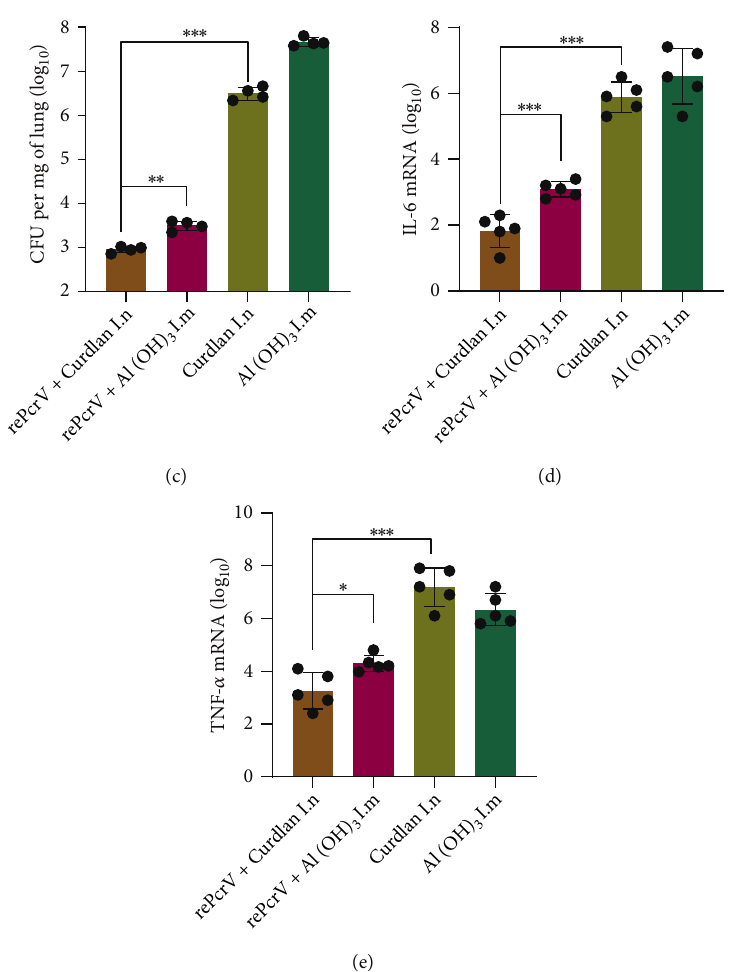
Figure 1: Intranasal vaccination (i.n.) with rePcrV enhanced protection compared with intramuscular vaccination (i.m.). (a) Schematic of the experimental protocol. The survival of immunized mice after challenge with the lethal dose ( 1 : 0 × 10 7 CFU ) of P. aeruginosa XN-1 ( n = 10 ). (b) H&E (hematoxylin and eosin) stain and histology scoring of pathology in lung tissues of immunized rePcrV + curdlan mice, immunized curdlan mice, and vaccinated Al(OH) mice ( n = 5 ). (c) Lung CFU in vaccinated mice, immunized rePcrV + Al(OH) 3 3 rePcrV + curdlan mice, vaccinated rePcrV + Al(OH) mice, vaccinated curdlan mice, and vaccinated Al(OH) mice ( n = 4 ). (d) IL-6 3 3 mRNA level in the lungs of immunized mice ( n = 5 ). (e) TNF- α mRNA level in the lungs of immunized mice ( n = 5 ). Data are shown as mean ± SEM . Signi fi cant di ff erences were calculated with Student ’ s t -test. ∗ P < 0 : 05 ; ∗∗ P < 0 : 01 ; ∗∗∗ P < 0 : 001 ; ∗∗∗∗ P < 0 : 0001